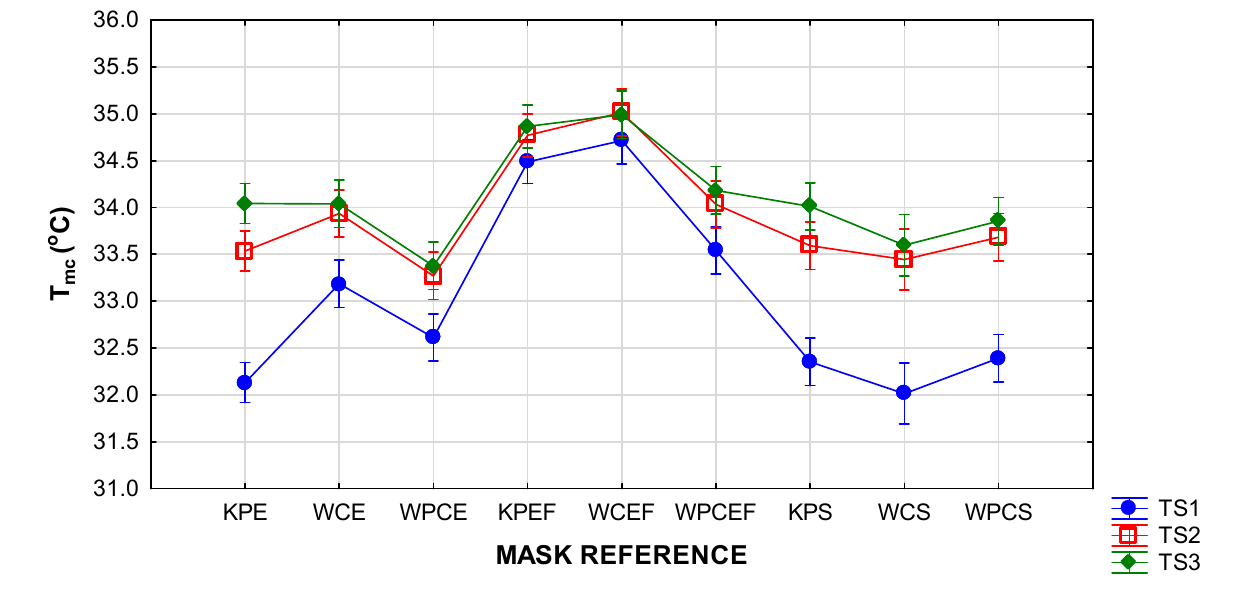
Figure 6. Two-way ANOVA of T mc per time segment according to mask design (referenced as explained in Table 1).